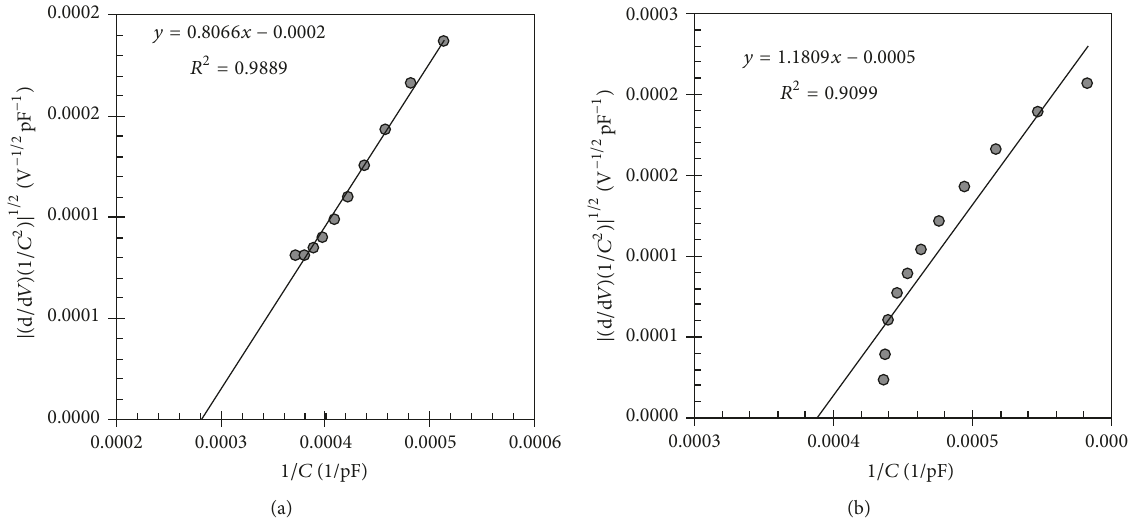
Figure 10: d (1/𝐶 2 )/ d 𝑉 versus 1/𝐶 plot for 100kHz for 𝐶